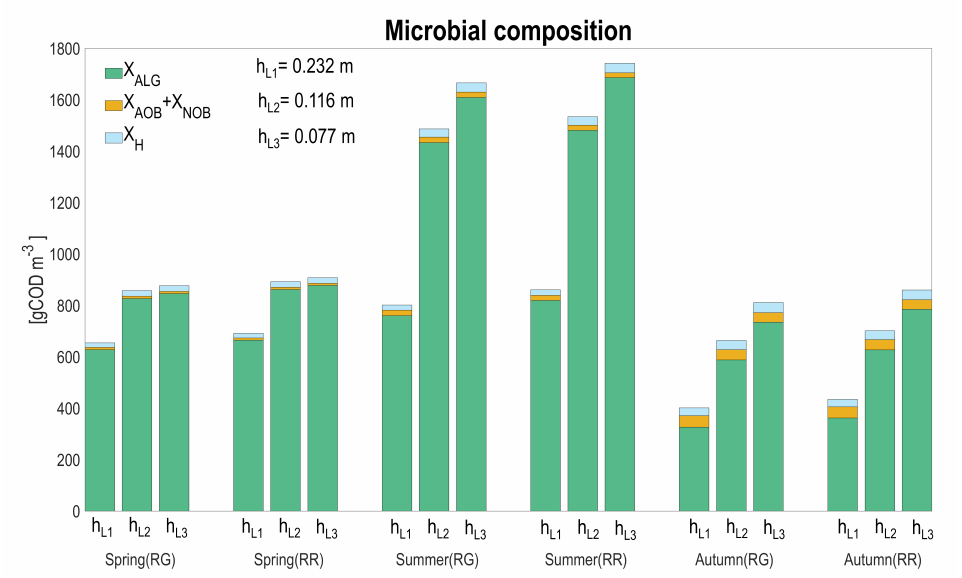
Figure 10. Seasonal average for biomass composition: algae ( X ALG ), ammonium oxidizing bacteria ( X AOB ), nitrite oxidizing bacteria ( X NOB ), heterotrophic bacteria ( X H ), for the two raceway configura- tions (RG: raceway on the ground, RR: raceway raised) and according to the three water depths. In general, the bacterial concentration is only marginally affected by